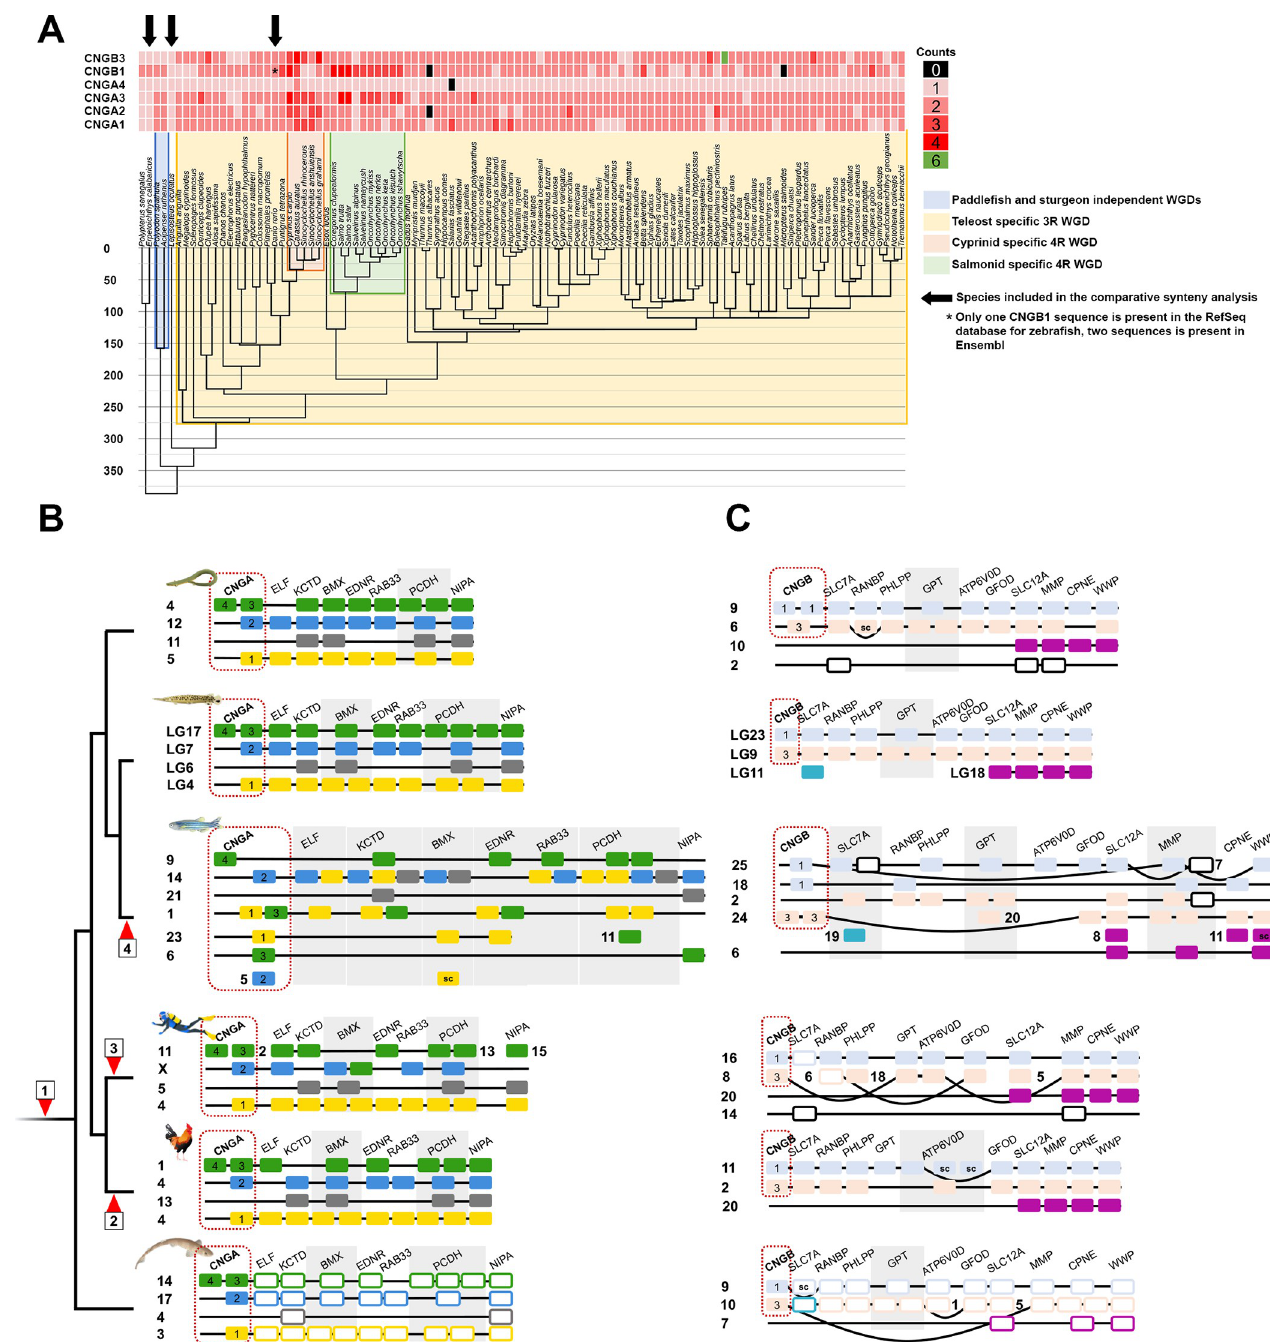
Fig 6. CNG sequence counts mapped to a time-calibrated phylogeny of ray-finned fish and comparative synteny analyses of CNGA and CNGB gene regions in select vertebrates. A ) A time-calibrated phylogeny retrieved from timetree.org of actinopterygian fishes and the CNGA and CNGB gene counts as a heatmap. Lineages marked with a colored background have experienced extra whole genome duplications. B) Chromosomal neighborhoods of CNGA genes in the spotted gar genome used in the phylogenetic analyses, and their orthologs, and their neighboring gene family members, in reedfish, zebrafish, human, chicken and small-spotted catshark. C) Chromosomal neighborhoods of CNGB genes in the spotted gar genome used in the phylogenetic analyses and their orthologs, as well as their neighboring gene family members, in reedfish, zebrafish, human, chicken and small-spotted catshark. Order of genes has been reshuffled to highlight similarities between the linkage groups within the paralogon and between species. The phylogenetic trees of the neighboring gene families are shown in S1-S17 Figs in S1 File. Red arrow heads represent: 1) 2R WGDs. 2) Chromosomal fusion in the chicken lineage; 3) rearrangements in the mammalian lineage; and 4) 3R WGD in teleost fish. Spotted gar chromosomes are colored as they are in Fig 1B and 1D, while the other animals’ orthologs are colored the same as their spotted gar ortholog–see Figs 6 and 7. Boxes for neighboring gene families in the small-spotted catshark have been left white with colored edges since they are not included in phylogenetic analyses. Numbers in gene boxes indicate which CNGA or CNGB gene the box represent. https://doi.org/10.1371/journal.pone.0279548.g006 PLOS ONE | https://doi.org/10.1371/journal.pone.0279548 December30,